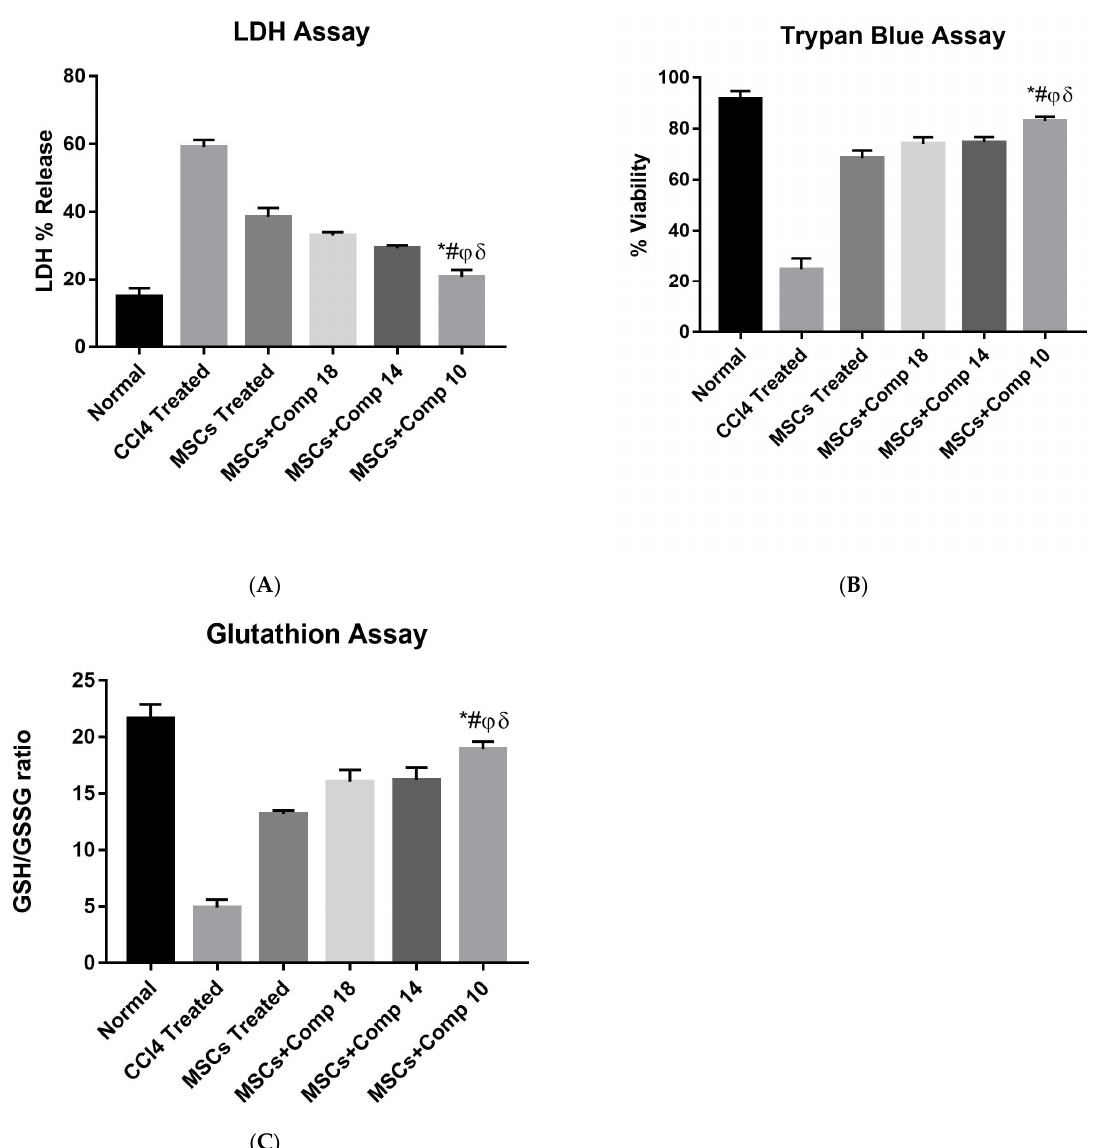
Figure 1. In vitro enhanced hepatocytes survival after treatment with MSCs + compounds: ( A ) LDH assay of hepatocytes co ‐ cultured with MSCs + compounds. % LDH release was significantly decreased in MSCs + compound ( 10 ) ‐ treated hepatocytes, compared to CCl 4 , only MSCs ‐ treated hepatocytes and MSCs + compounds ( 18 ) ‐ and ( 14) ‐ treated hepatocytes, as shown by bars (*). ( B ) Cell viability assay of hepatocytes co ‐ cultured with MSCs + compounds. Cell viability was highly increased in MSCs + compound ( 10 ) ‐ treated hepatocytes, compared to CCl 4 ‐ treated, only MSCs ‐ treated hepatocytes and + MSCs + compound ( 18 ) ‐ and ( 14 ) ‐ treated hepatocytes, as shown by bars with alphabet letter (*). ( C ) Glutathione assay of hepatocytes co ‐ cultured with MSCs + compounds. GSH level was significantly increased in MSCs + compound ( 10 ) ‐ treated hepatocytes, compared to CCl 4 ‐ treated, only MSCs ‐ treated hepatocytes and MSCs + compounds (Co Cultured) ‐ and ( 14 ) ‐ treated hepatocytes, as shown by bars with symbols *. Mean ± SEM (n = 3). Bars with symbols show significance with each other. * p < 0.02 for MSCs+Comp10 vs. CCl4; # p < 0.05 for MSCs + Comp10 vs. MSCs; φ p < 0.05 for MSCs + Comp10 vs. MSCs+Comp18; δ p < 0.05 for MSCs + Comp10 vs. MSCs + Comp14.